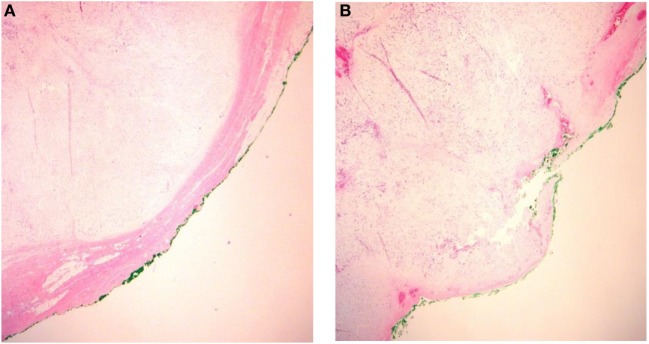
Integrity of the pleomorphic adenoma capsule. (A) Capsular integrity preserved and (B) ruptured capsula.